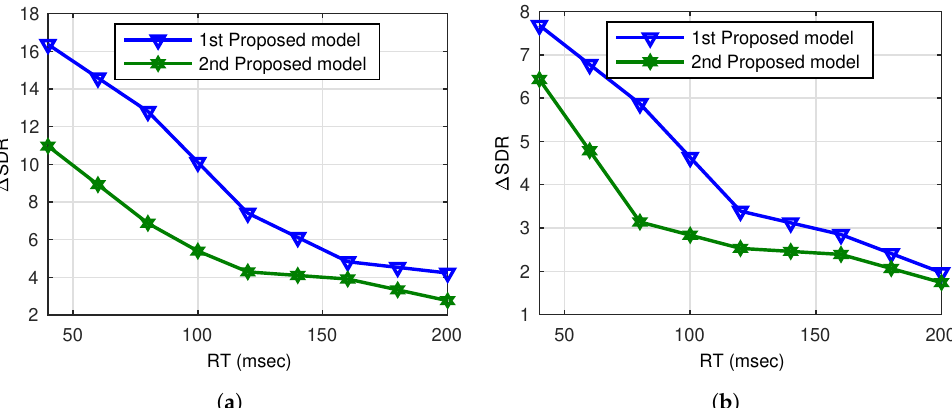
Figure 10. ( a ) Comparison of the two proposed models for ˆ S 1 with variable RT (msec); ( b ) Compari- son of the two proposed models for ˆ S 2 with variable RT